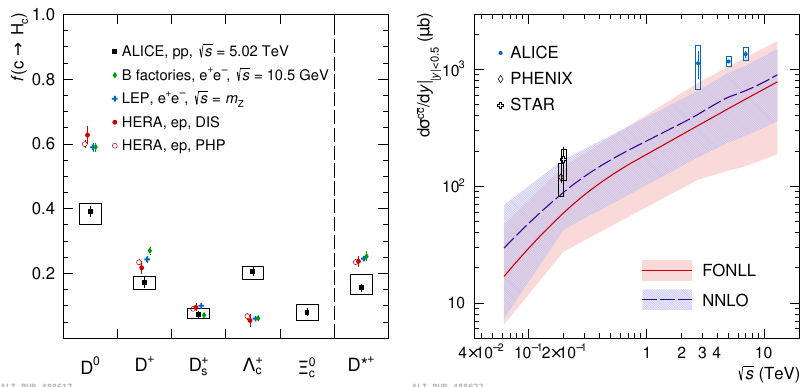
Figure 2: Left: Charm-quark fragmentation fractions into charmed hadrons measured in (cid:112) s = 5.02 TeV in comparison with experimental measurements performed in pp collisions at e + e − collisions at LEP and B factories, and in ep collisions at HERA. Right: Charm production cross section at midrapidity per unit of rapidity as a function of the collisions energy [ 7 ]